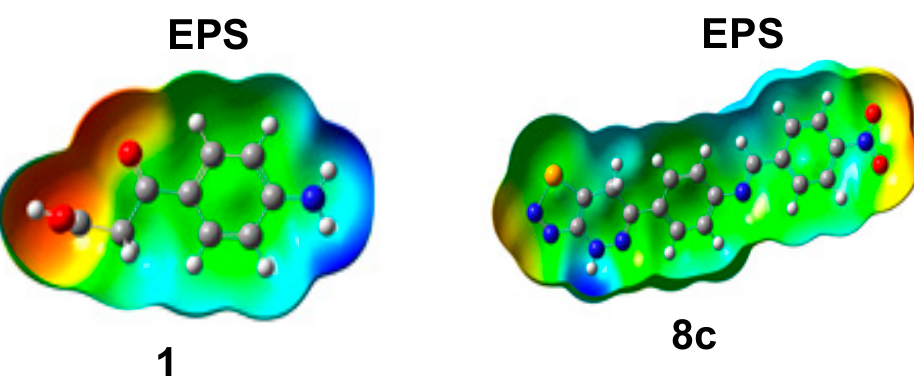
Scheme 4. Representative molecular electrostatic potentials (MESP) mapped on the electron density surface calculated by the B3LYP/6-31+G(d) method for compounds 1 and 8b. Symbols are O (red), C (gray), H (white), and N (blue). The electrostatic potential increases in the order red (electrophilic) < orange < yellow < green < blue (nucleophilic).